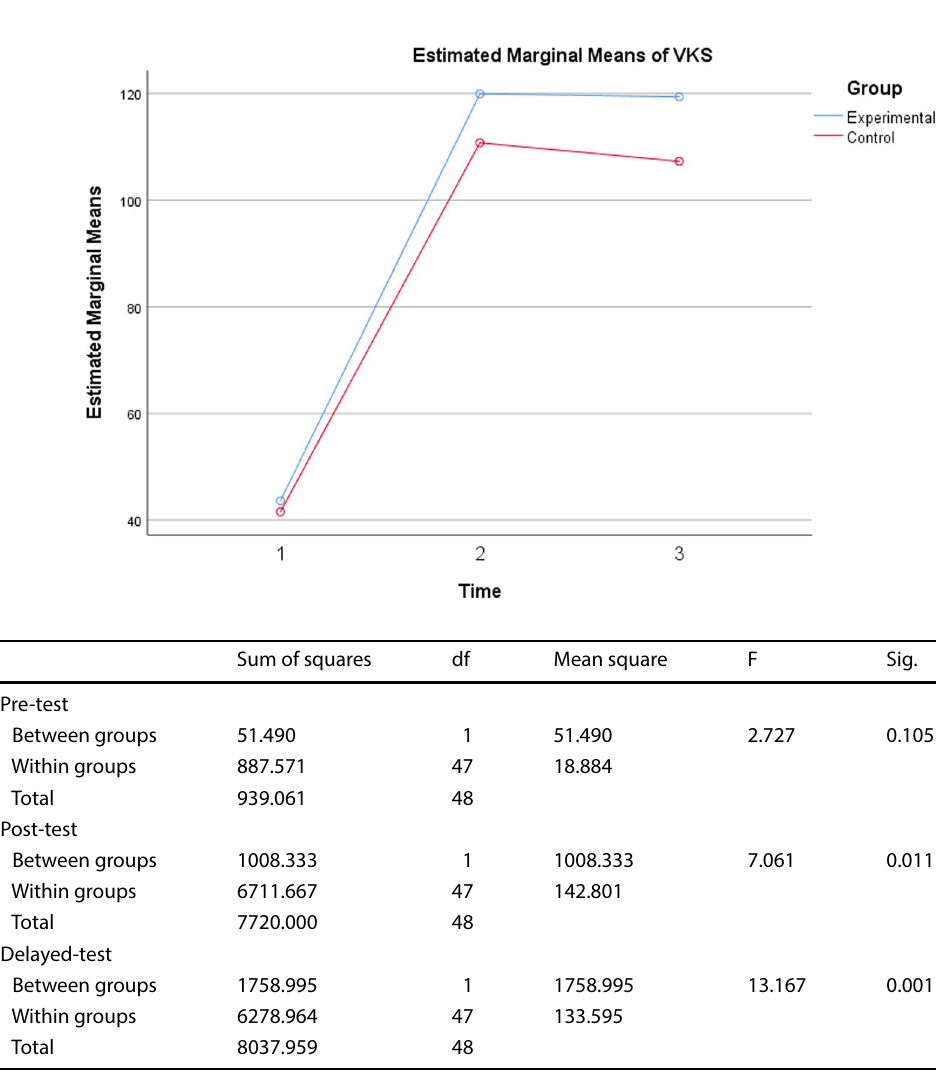
Table 4 Tests of between- subjects